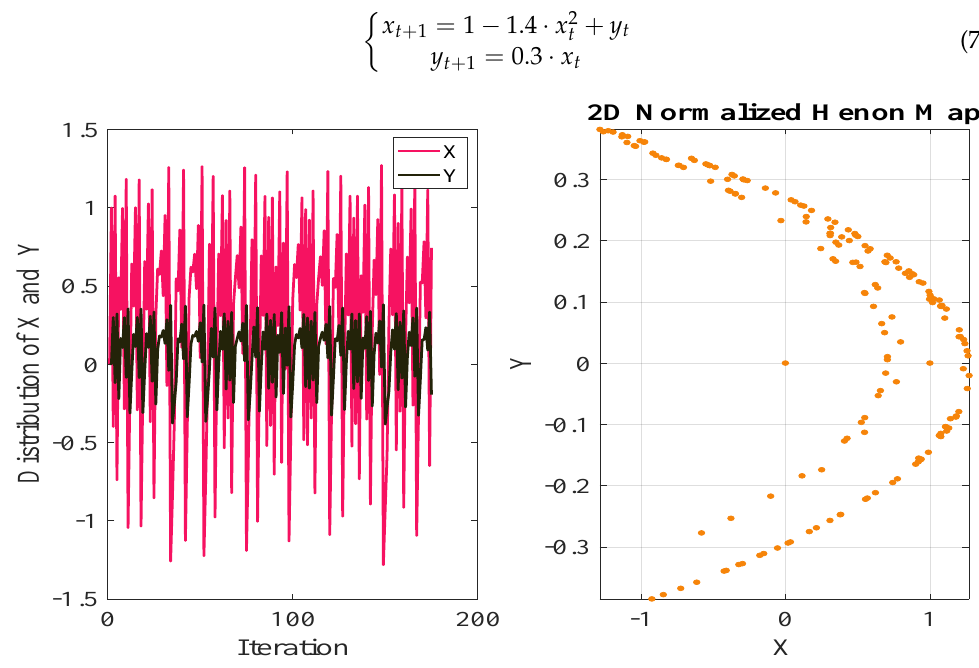
Figure 1. Hénon attractor, and x , y